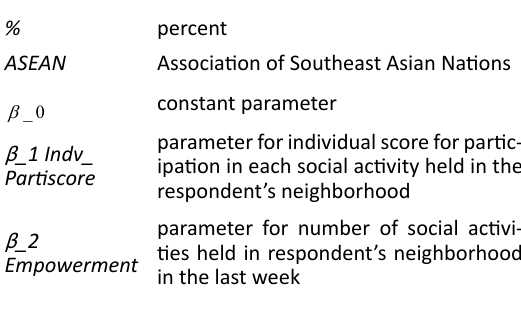
score of an individual’s participation in garbage-related activities (e.g. neighbor Garbagescore